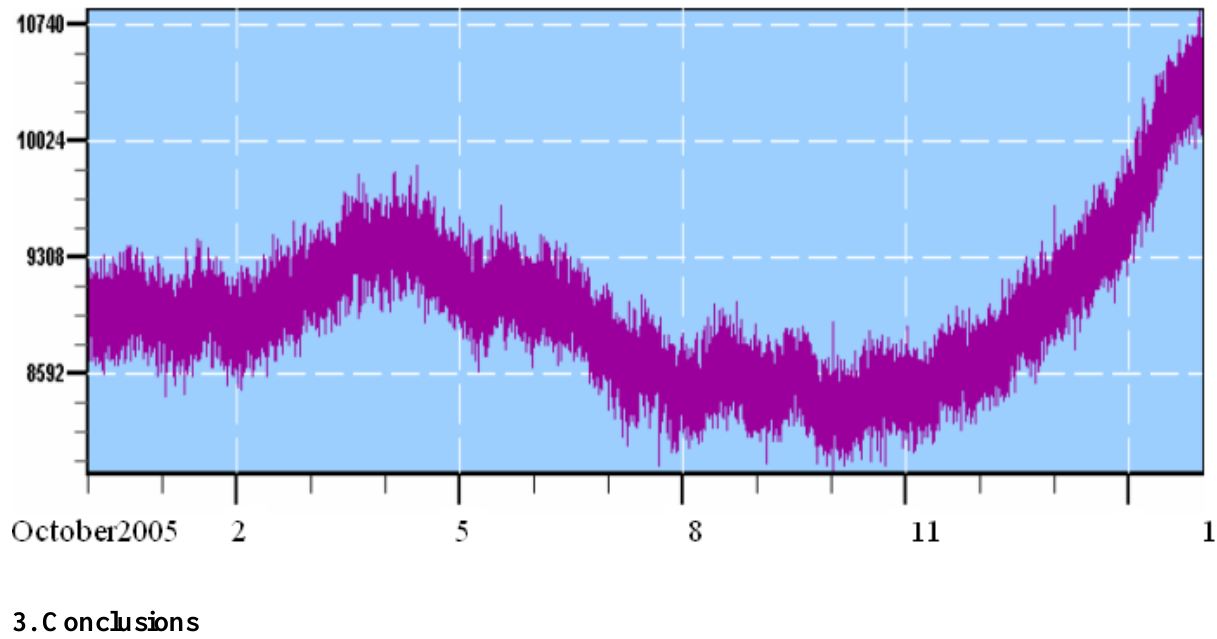
Figure 3. Cosmic ray variation before snowfall and subsequent earthquake on 8th October 2005, establishing forebursh effect and its relation with environment of the Earth (shown in between 8000 to 8100 as low during earthquake and 10740 as high after